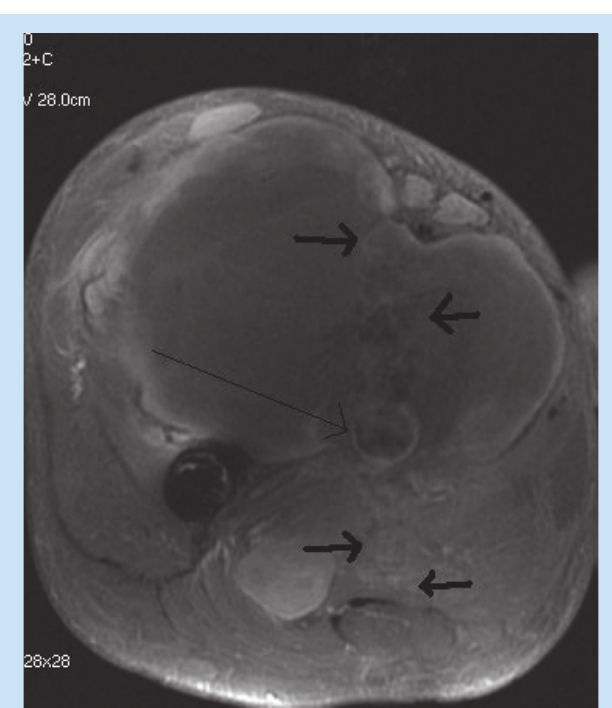
Fig. 1b. Post contrast axial T1 shows central minimal enhancement (arrow) and the pulsation artifact in the phase-encoding direction (AP) indicating the vascular origin of the lesion (thick arrows).